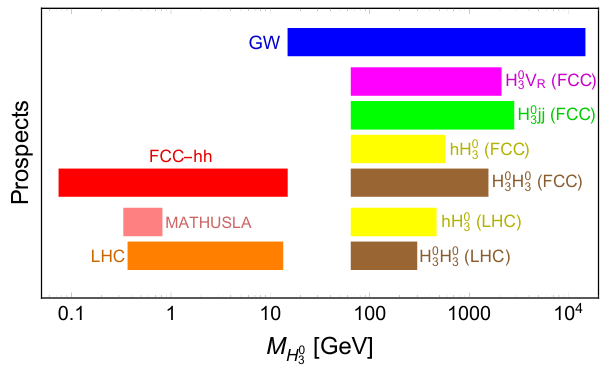
at the colliders and GWs: the orange, pink and red bands are Figure 10 . Complementarity of H 0 3 the prospects of a light H 0 at FCC-hh (100 TeV and 30 ab − 1 ), MATHUSLA and LHC (14 TeV and 3 3 ab − 1 ), the brown, yellow, green and magenta bands are the prospects of direct searches of H 0 the FCC-hh (and LHC) in the channels H 0 , hH 0 , H 0 H 0 jj and H 0 V R . The blue band is the GW 3 3 3 3 3 prospect of H 0 mass in the right panel of figure 3